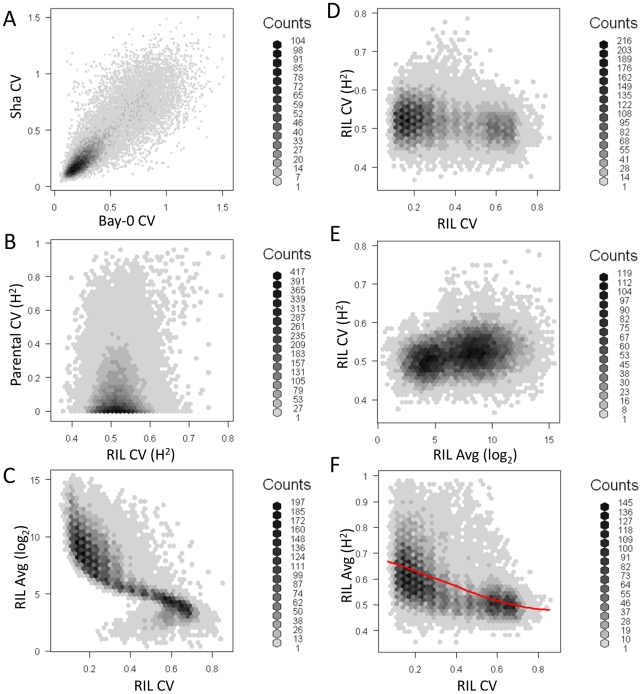
Relationship of transcript CV to heritability and average expression.Heritability, average expression and CV for Bay, Sha and the RILs was measured for all 22,746 transcripts. Graphs are hexbin histograms with the counts per hex shown to the right of each graph. (A) Correlation of measured transcript CV in Bay and Sha. (B) Comparison of transcript CV heritability in the Parents and RILs. (C) Comparison of average transcript expression and average transcript CV within the RILs. (D) Comparison of transcript CV heritability and average transcript CV within the RILs. (E) Comparison of transcript CV heritability and average transcript abundance within the RILs.